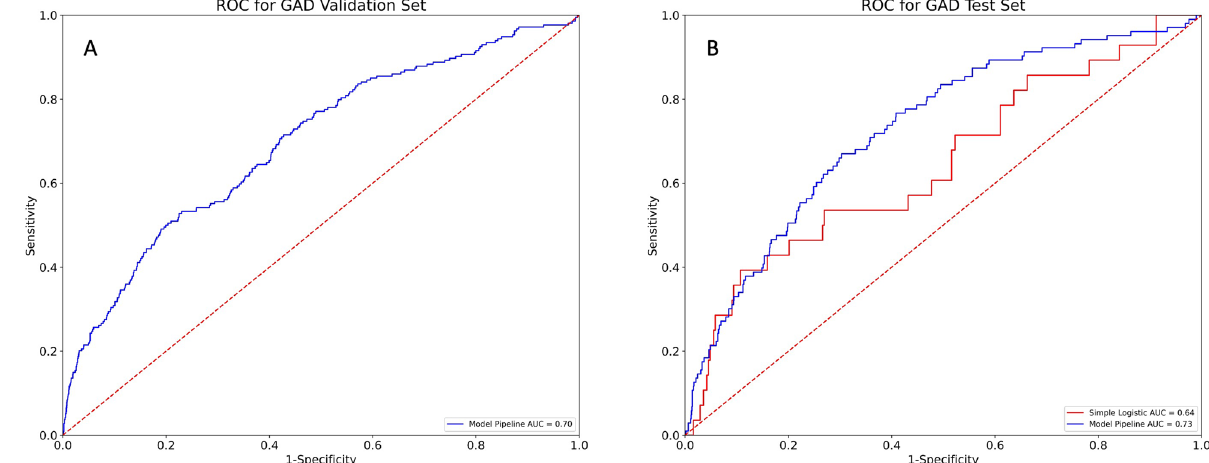
Figure 3. ( A ) AUC for prediction of GAD in the training set. ( B ) AUC for the prediction of anxiety in the held- out test set using both a simple logistic regression and our novel pipeline for prediction. These curves show the sensitivity and specificity at different thresholds for prediction.